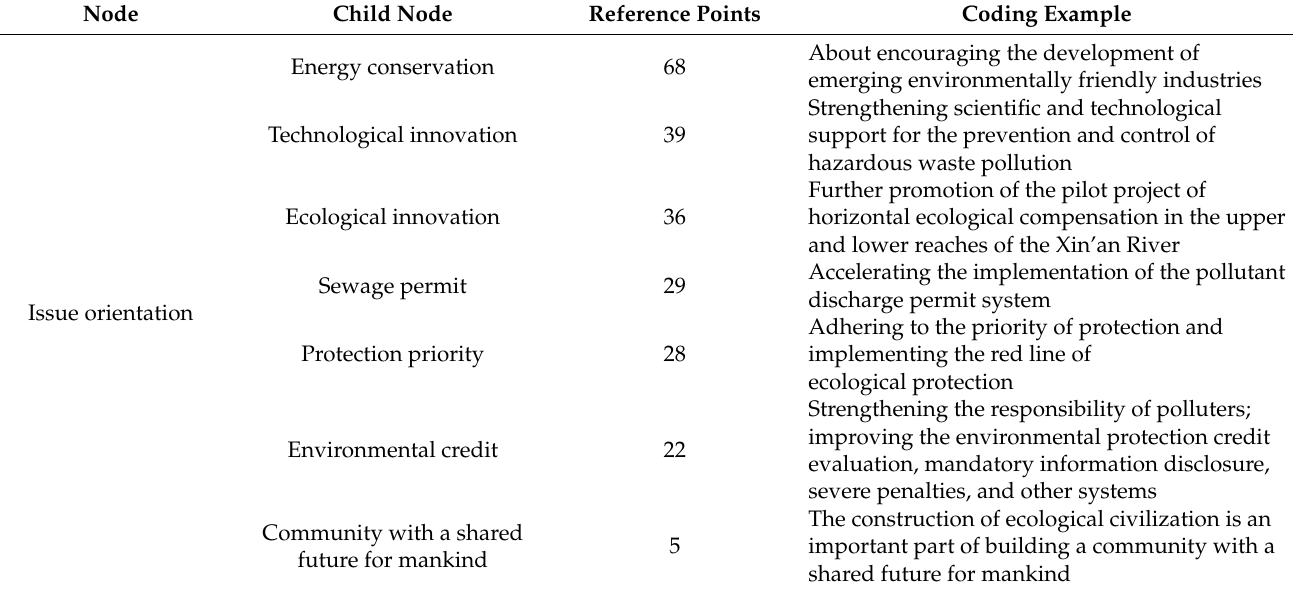
Table 5. “Issue orientation” node hierarchy and coding information